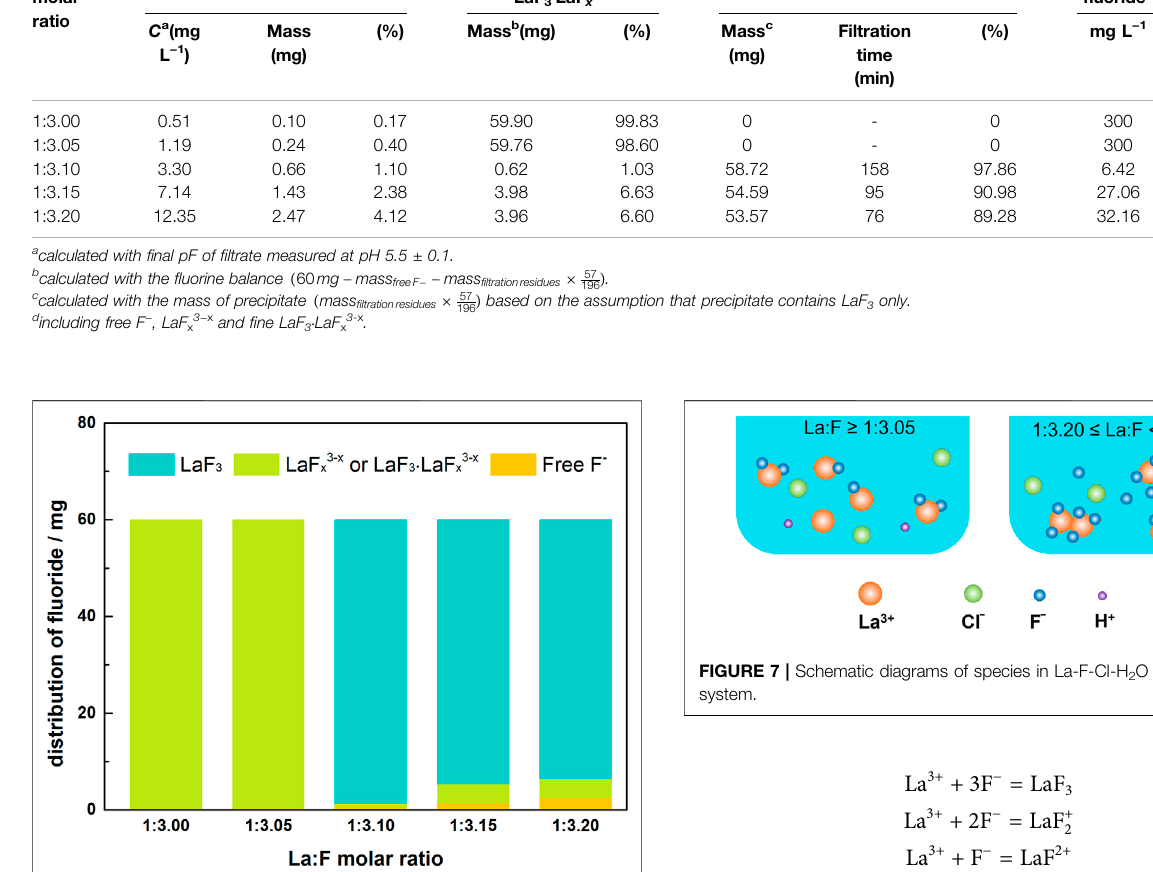
TABLE 3 | Distribution of fl uorine element in aqueous solutions with La/F molar ratios ≤ 1:3.00 after reaction for 1 h. La/F molar